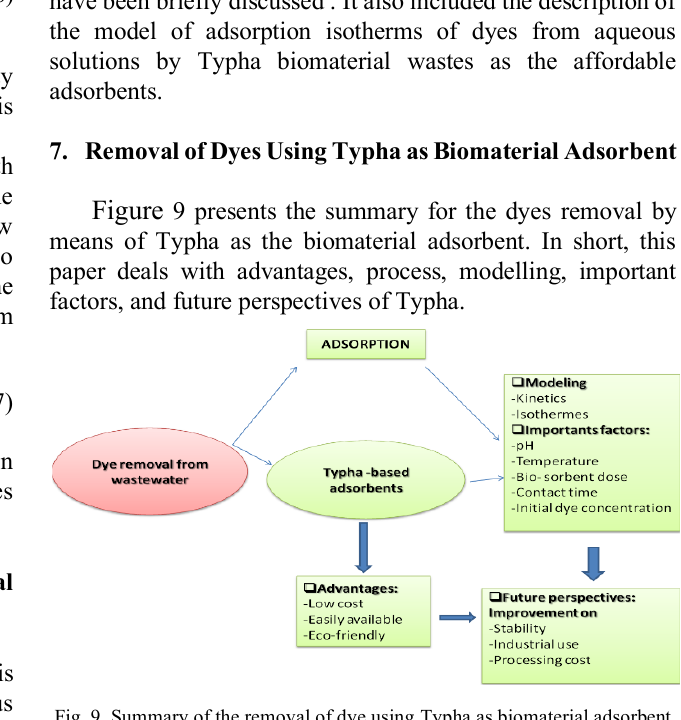
Fig. 9. Summary of the removal of dye using Typha as biomaterial